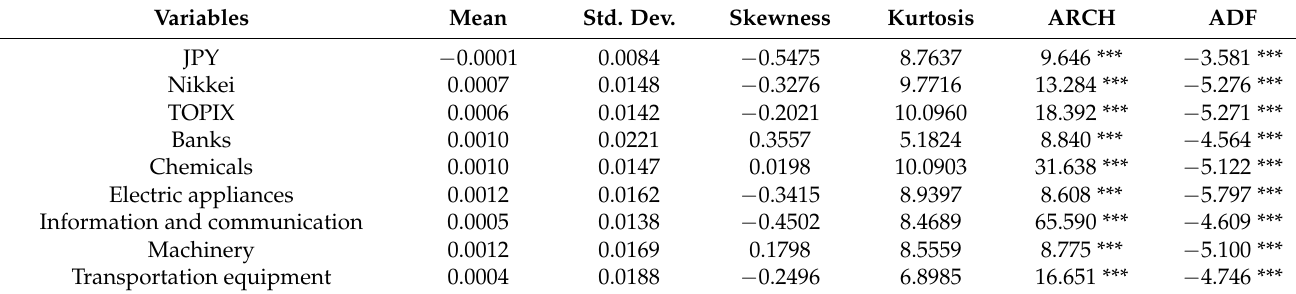
Table 1. Daily logarithmic returns of the exchange rates and stock price indices. Author’s estimations based on the data from the Bank of Japan, TSE and Yahoo Finance. The total number of observations is 275. The maximum number of lags for the augmented Dickey–Fuller (ADF) test selected by the Schwarz–Bayesian information criterion is 15. For the ARCH test, *** indicates that the null hypothesis of no ARCH (1) effects at a 1% significance level is rejected. For the ADF test, *** indicates values less than the critical value at a 1% significance